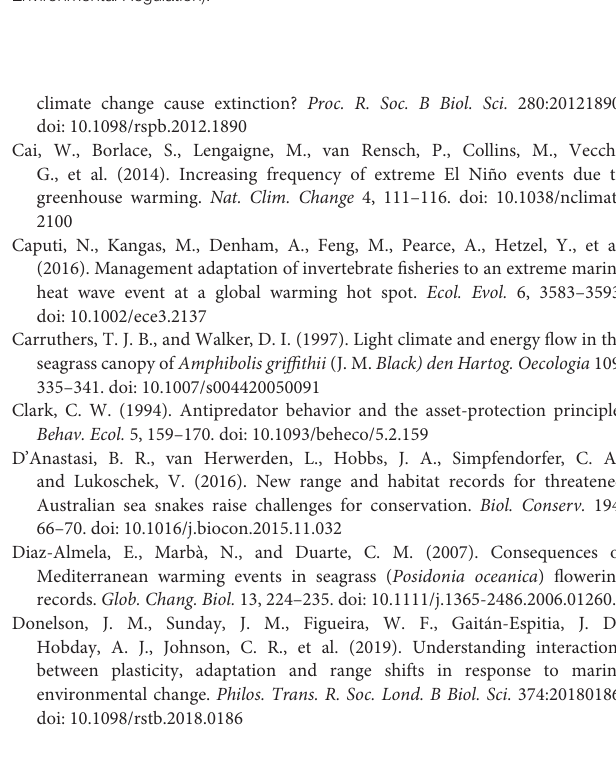
Table S1 | Impacts to marine organisms and data sources by year before, during and after the 2011 MHW in Shark Bay. All cited papers are in the reference list of the main paper. Table S2 | Stem and shoot density (Mean, SE, and n ) for Amphibolis antarctica and Posidonia australis , respectively, for field programs in Shark Bay held between 1982 and 2018. Table S3 | Description of results of a one way ANOVA and post-hoc Tukeys HSD statistics with field trip as the factor and shoot density of Posidonia australis and stem density of Amphibolis antarctica as dependent variables. Table S4 | Posidonia australis inflorescence densities and seed production between 2011 and 2018. Table S5 | Wooramel River Discharge by month (megaL) and sea temperatures between 1994 and 2015 (courtesy of WA Dept. of Water and Environmental